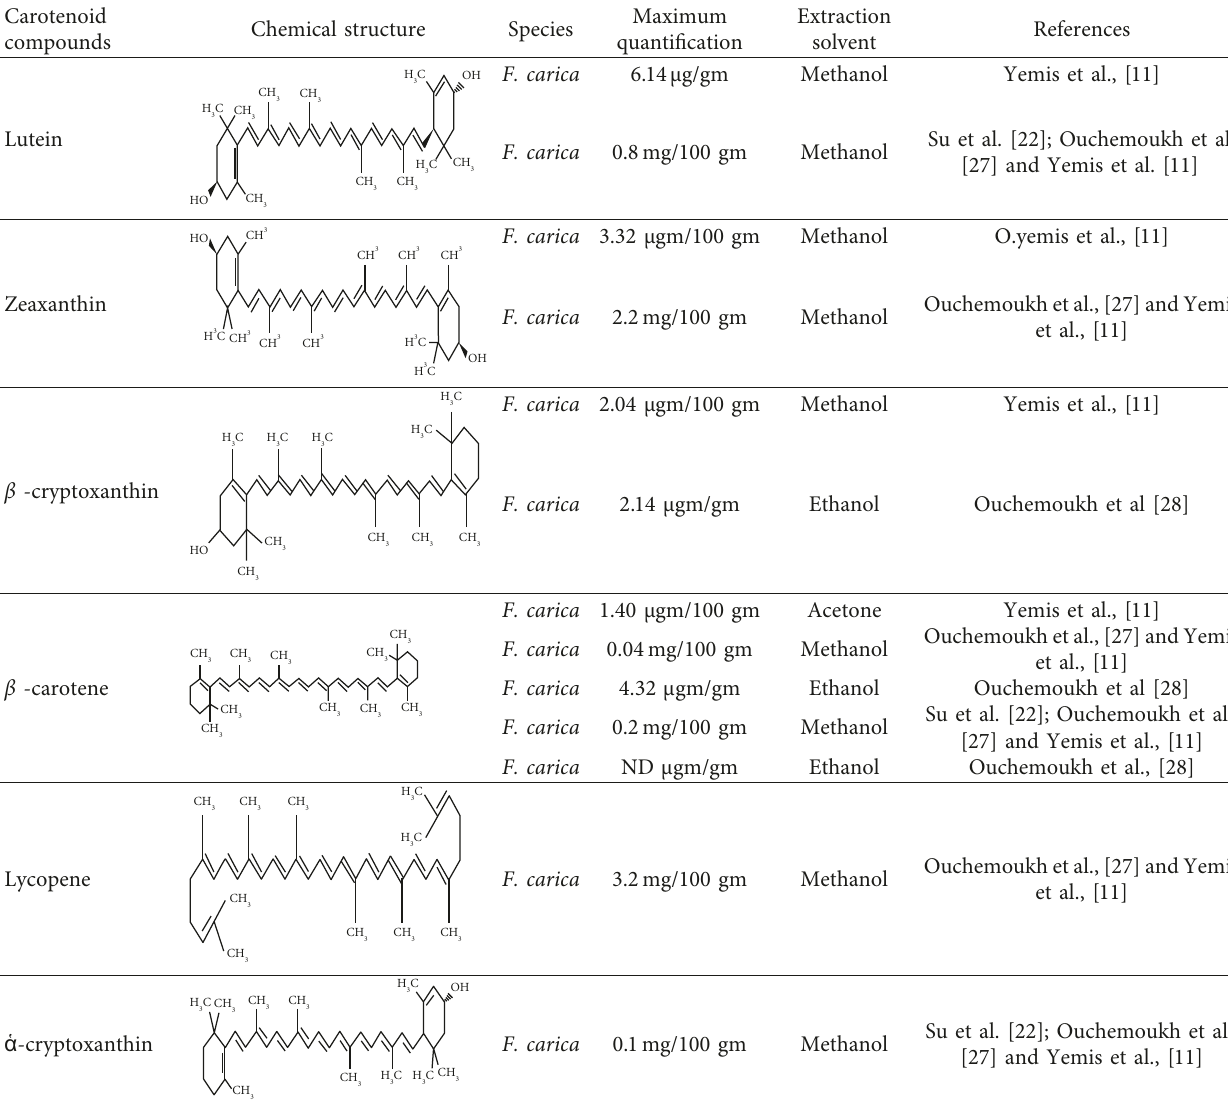
Table 2: Carotenoid compounds present in the species used as both fresh fruit and species belonging to genus Ficus . Carotenoid compounds